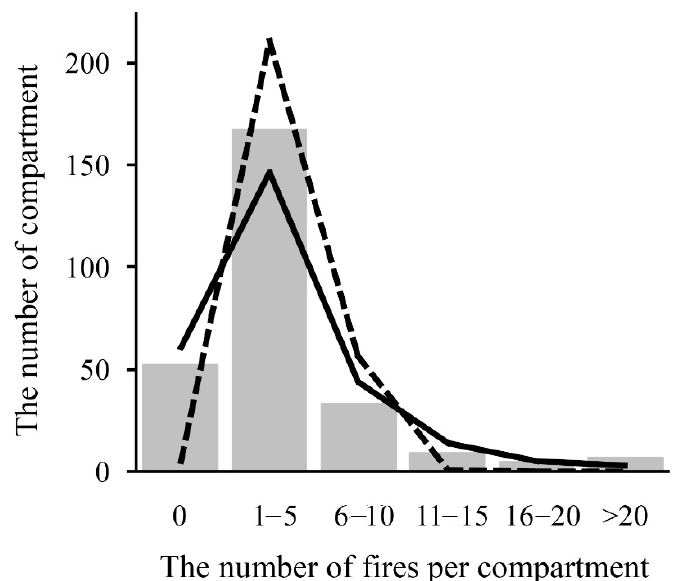
Figure 4. The approximations of the distribution of the number of fires in the compartments of the Ilmensky Reserve (gray bars) by the Poisson distribution (dashed line) and the Inverse Binomial distribution (solid line). Table 1. The distribution parameters for the number of fires in the compartments of the